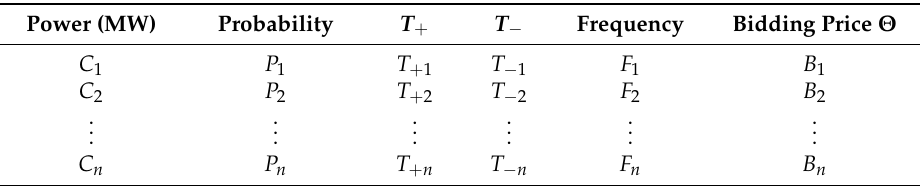
Table 1. Wind farm output power stochastic model. Power (MW) Probability T + T −